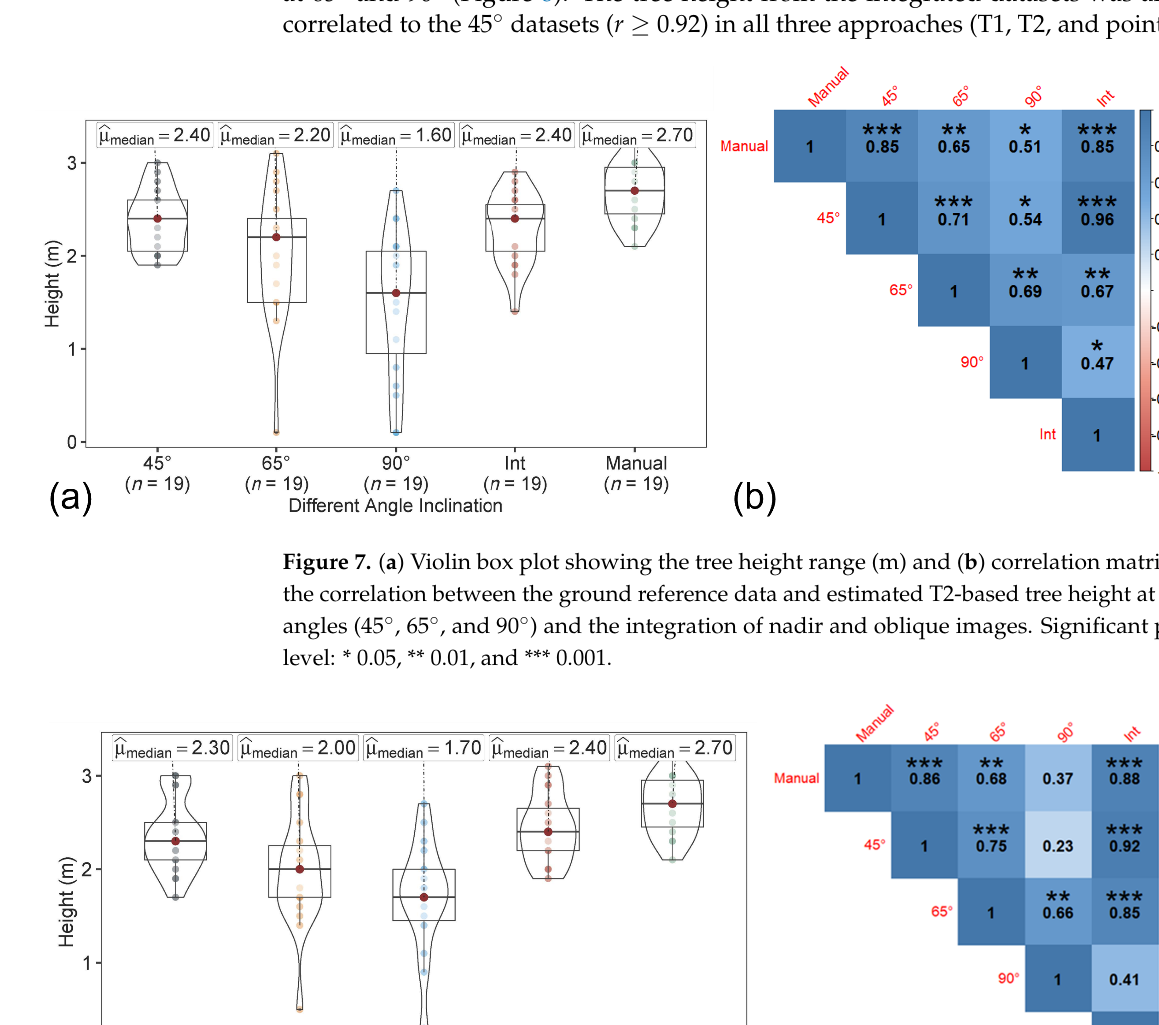
Figure 8. ( a ) Violin box plot showing the tree height range (m) and ( b ) correlation matrix showing the correlation between the ground reference data and UAV point cloud-based estimated tree height at individual angles (45°, 65°, and 90°) and the integration of nadir and oblique images. Significant probability level: * 0.05, ** 0.01, and *** 0.001.